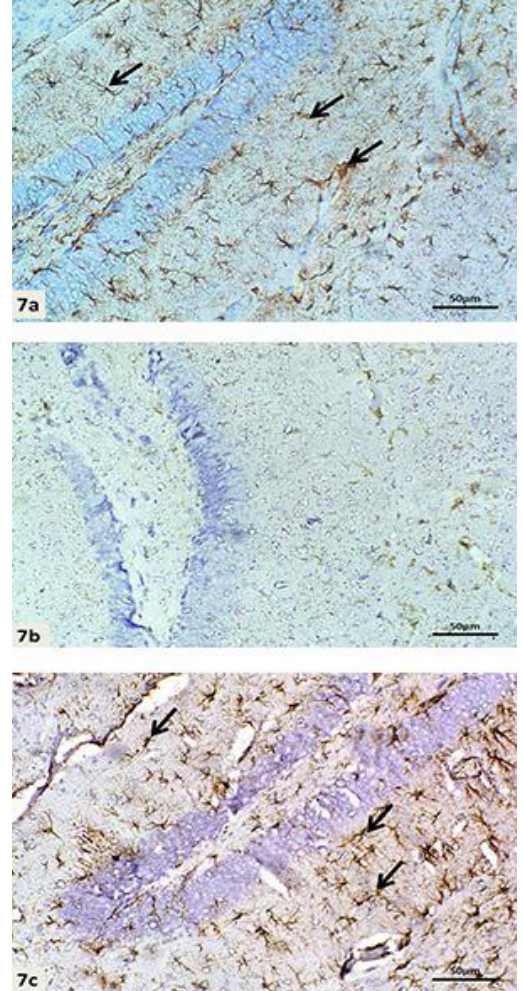
Optical Area% of density of Area% of cresyl cresyl GFAP violet violet